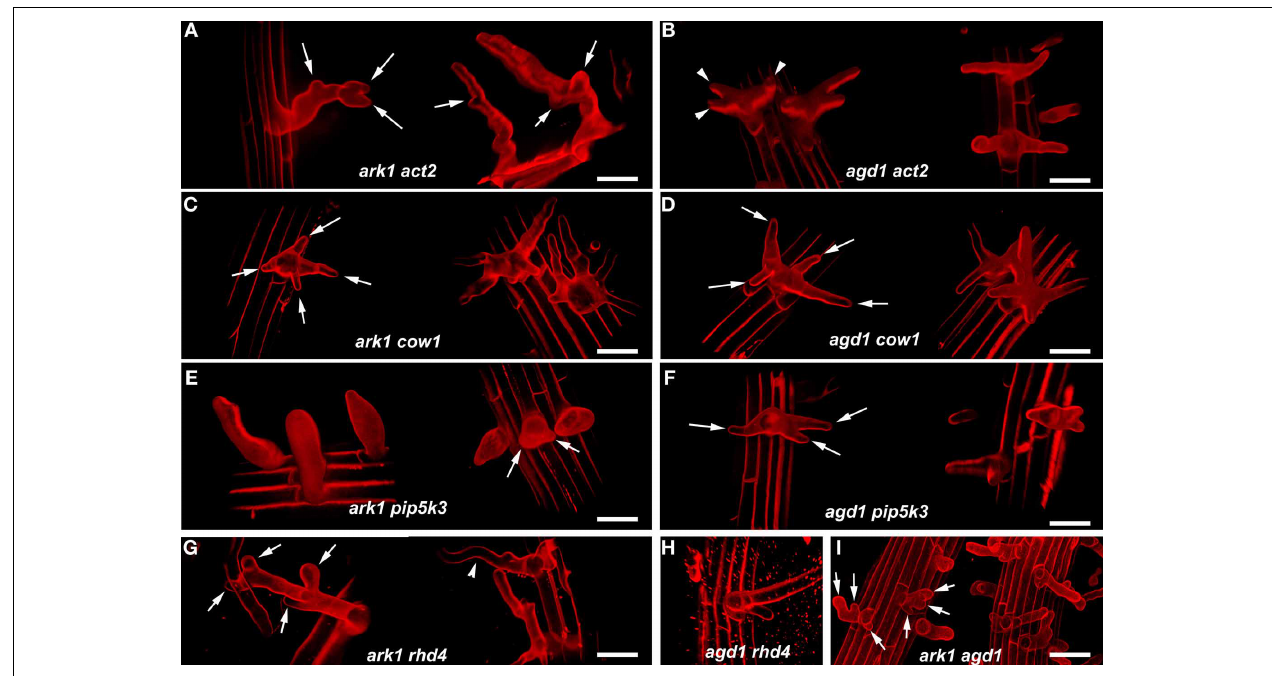
FIGURE 2 | Representative confocal microscope images of various ark1 and agd1 double mutants. Roots were stained with propidum iodide and a series of optical sections were projected and rendered using Volocity 6.3 software to more accurately visualize the resulting shapes of the double mutants. (A , B) Note that multiple root hair tips appear to emerge at various points in elongating ark1 act2 root hairs (arrows) while multiple tips in agd1 act2 are restricted to early initiation (arrowheads). (C,D) In ark1 cow and agd1 cow1 , multiple root hairs tips are prevalent at a single initiation point (arrows). (E,F) Bulbous root